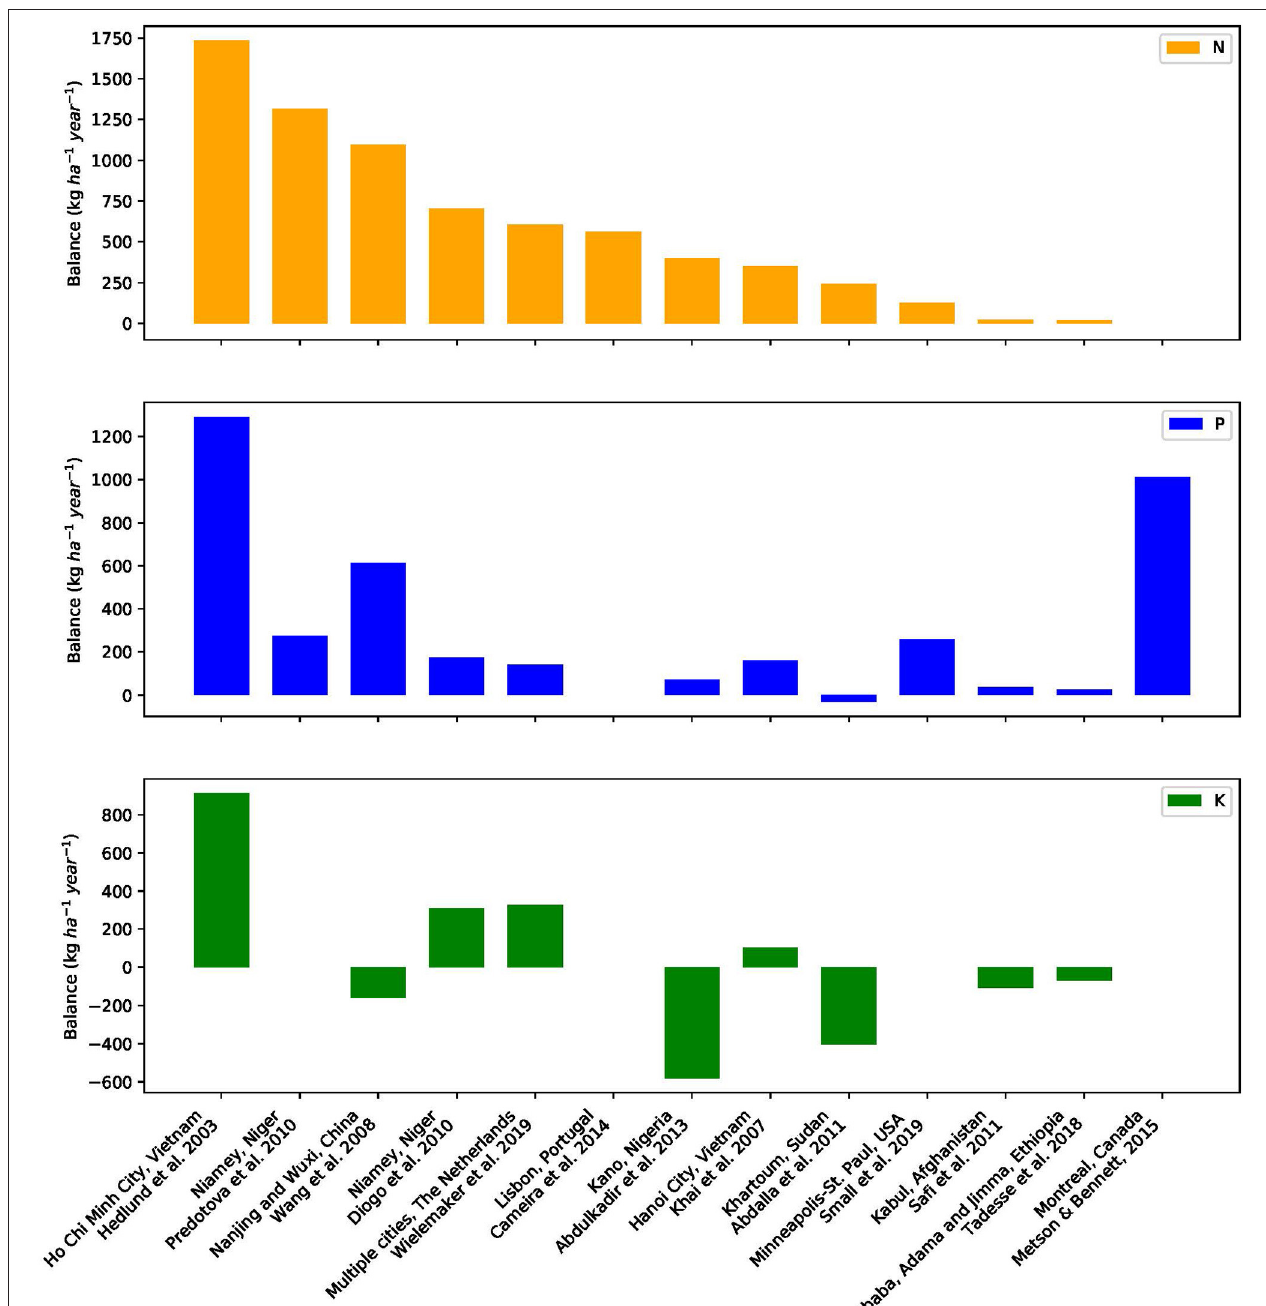
FIGURE 2 | Average garden-gate nutrient balances for the studies that quantified inputs and outputs for each nutrient. Note that there is no nitrogen (N) value for Montreal and no phosphorus (P) value for Lisbon. Potassium (K) values are absent for Montreal, Niamey, Lisbon, and Minneapolis-St. Paul. The order of the cities is kept constant across all three panels, moving from the highest N balance (left) to the lowest